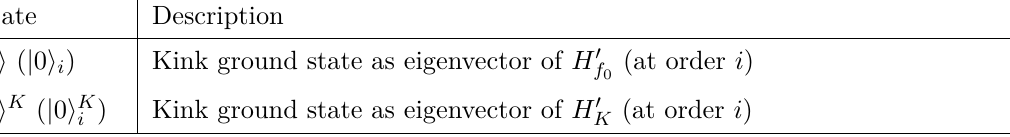
Table 1 . Summary of